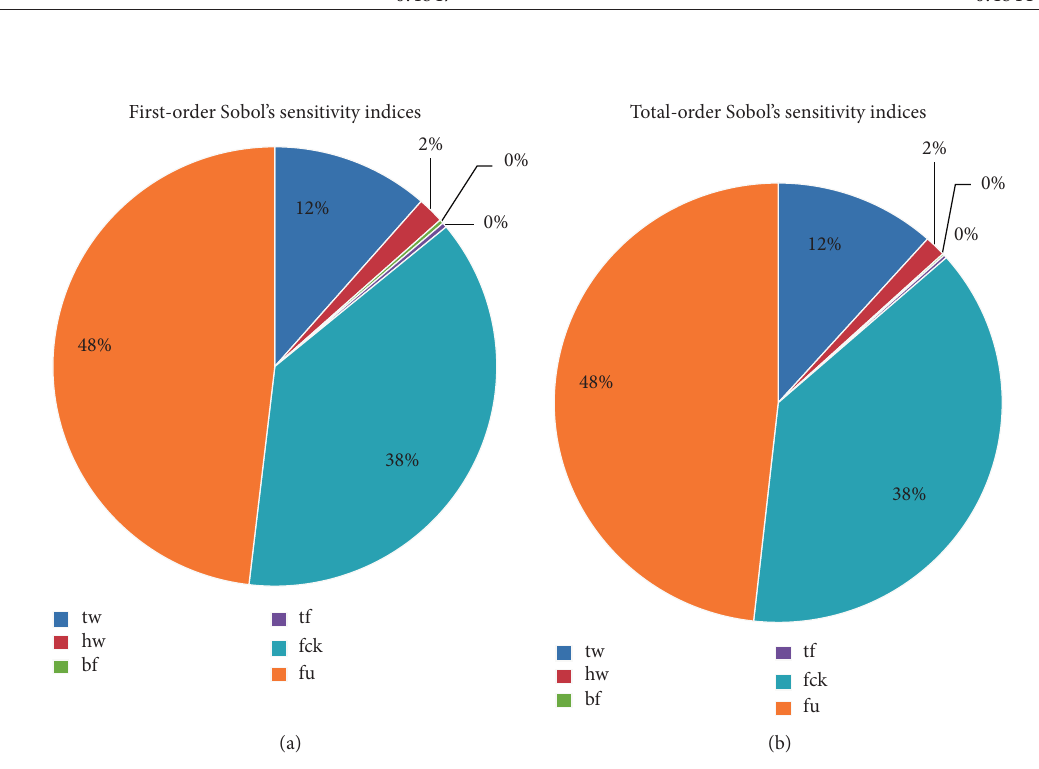
Figure 13: First-order and total Sobol’s sensitivity indices of the 20-year corroded SCC beams.